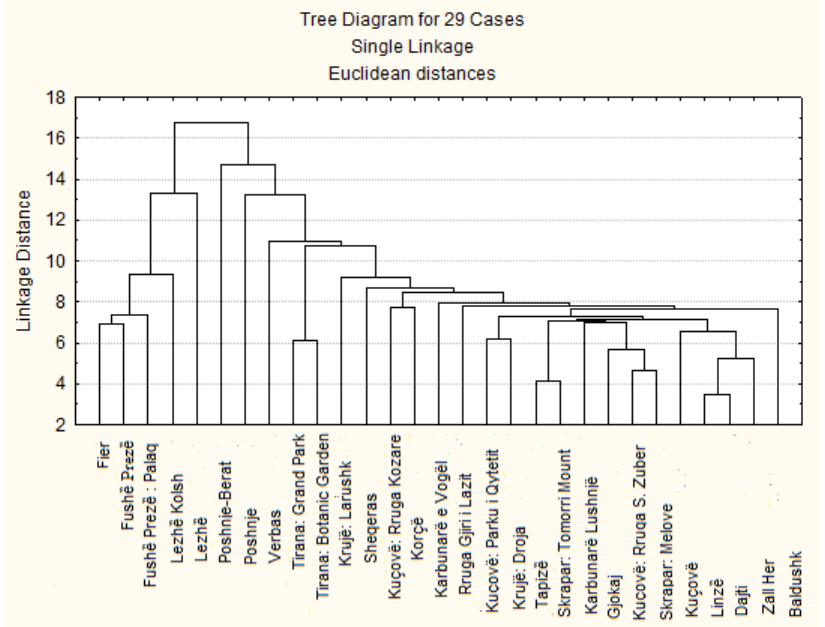
Figure 3. Dendrogram of relationships among Albanian chamomile populations and qualitative– quantitative characteristics of essential